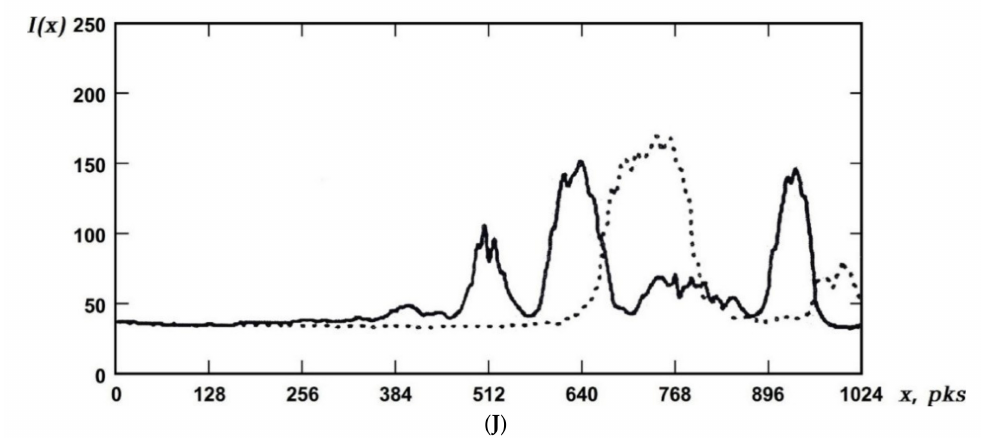
Figure 4. Dependences of the changes in the optical field intensities of interference patterns along X -axis for the simulation options shown in Table 1. ( A ) Option 1; ( B ) Option 2; ( C ) Option 3; ( D ) Option 4 ( E ) Option 5; ( F ) Option 6 ( G ) Option 7; ( H ) Option 8; ( I ) Option 9; ( J ) Option